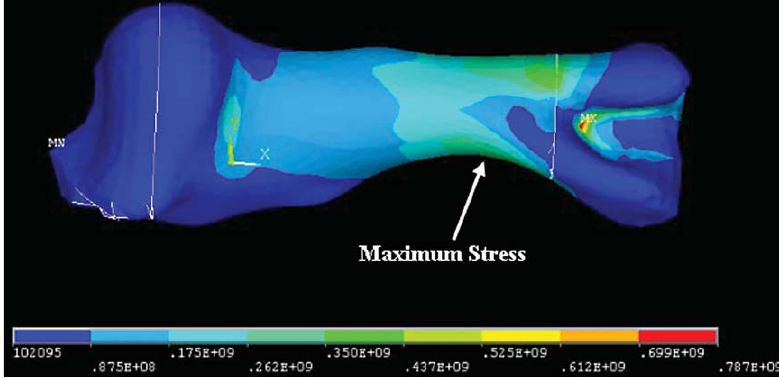
Fig. 8. Stress distribution in complete test with the muscle forces considered, when the humerus was forming an angle (cid:2) of 75 ◦ with the horizontal plane (see Fig. 5).